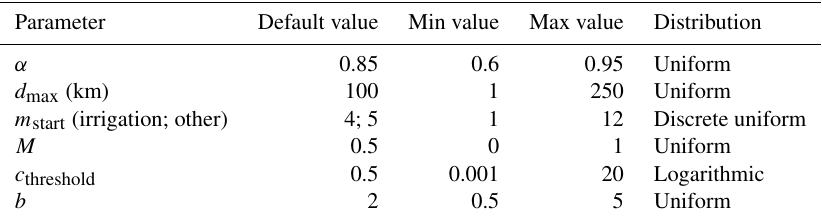
Figure 2. Main characteristics of the chosen reservoirs. (a) Classification of their main purpose, (b) distribution of simulation period lengths, and (c) histogram showing decimal log values of their relative capacity. Table 2. Summary of the DROP model parameter default values and feasible ranges for the sensitivity